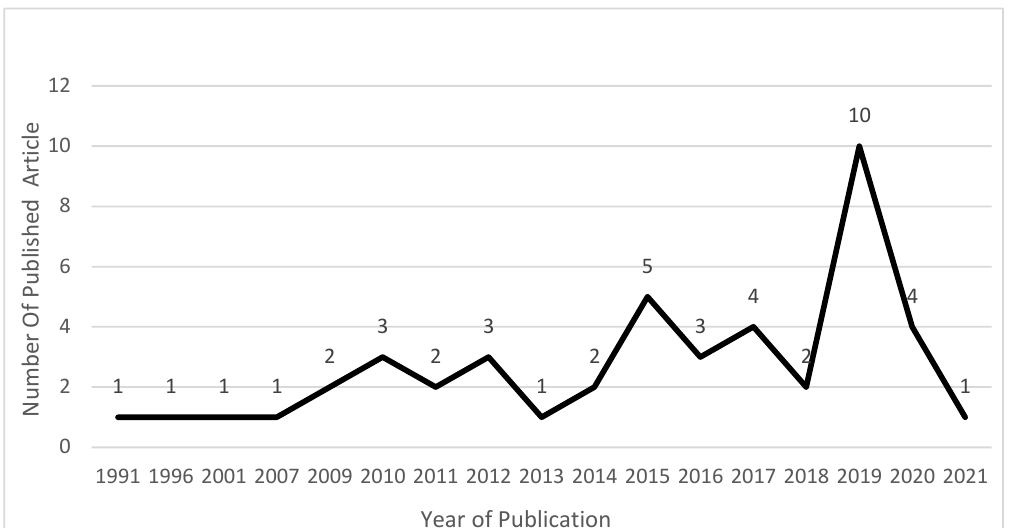
Figure 2. Distribution number of articles published between 1991 to 2021. Table 5. Frequency table on country where the selected studies conducted. Country Estate Planning